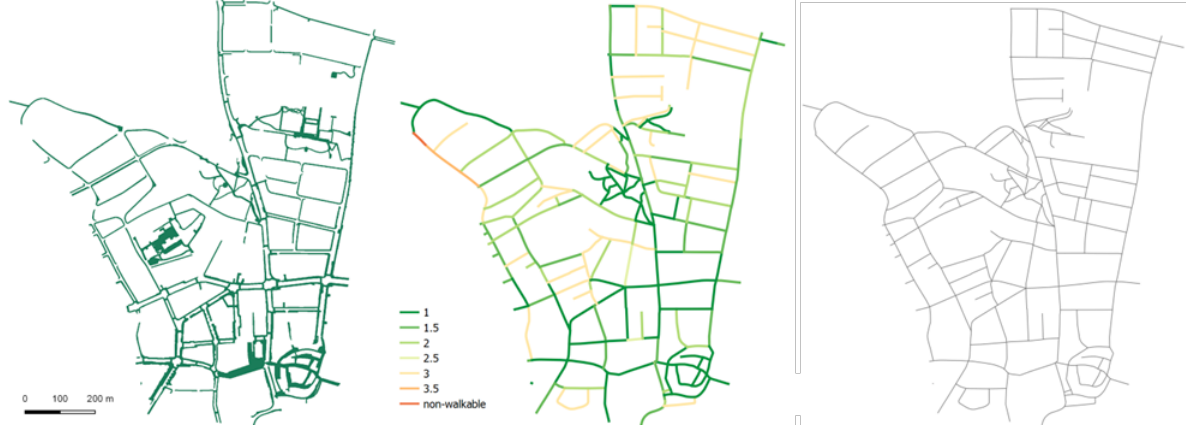
Figure 1. Footpath network 1 (left) comprising car traffic free paths only; footpath network 2 built from walkability rated streets (middle, the colour coding is explained in Table 1); and the unrated street network (right). (Data sources: Amt für